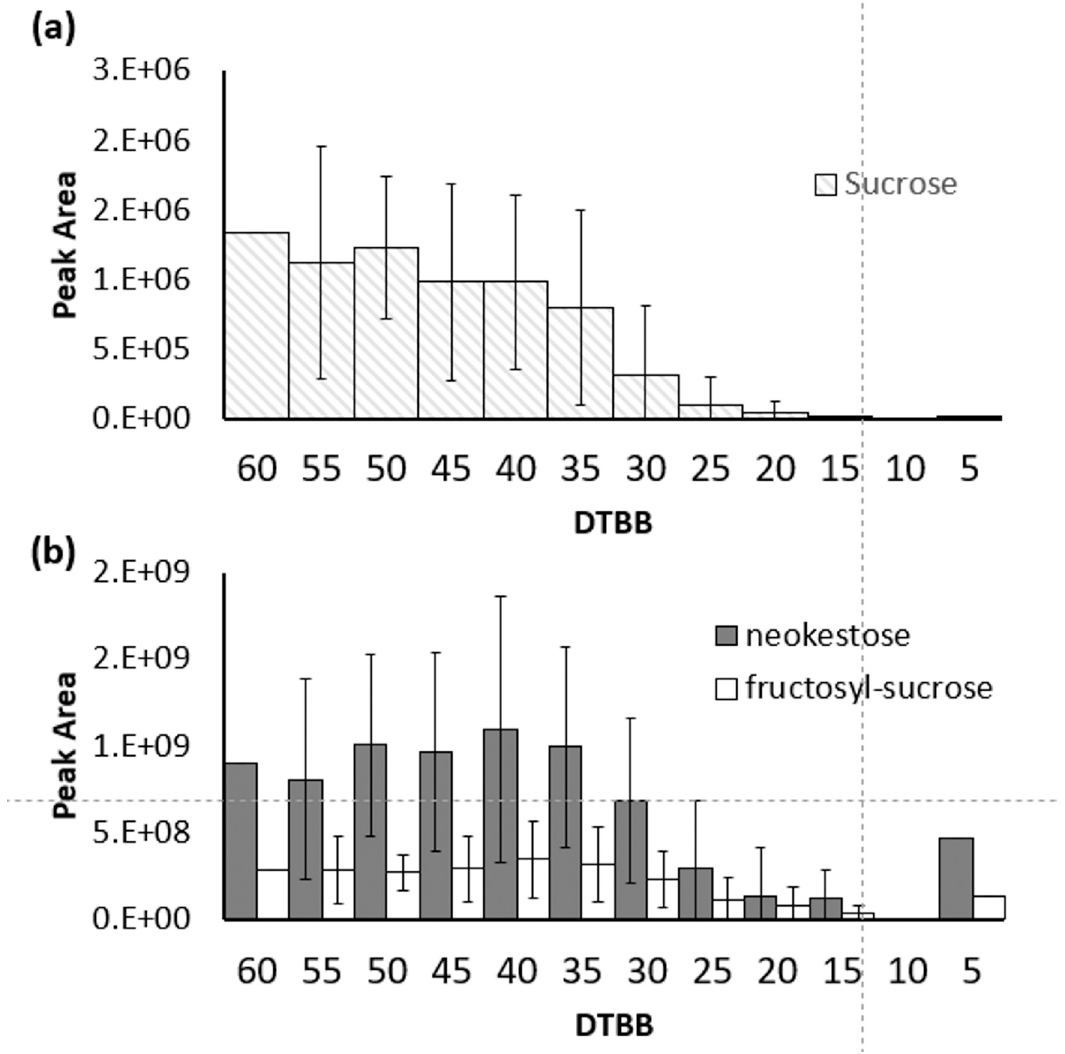
Fig 6. Average peaks areas of (a) sucrose and (b) the trisaccharides neokestose and fructosyl-sucrose. Samples were plotted in bins of 5 DTBB units across the 2019 season. Significant variations in the amounts of sucrose and trisaccharides present existed across the regions; however, the general trend showed relatively stable concentrations before 40 DTBB. Concentrations rapidly decreased towards the end of the production